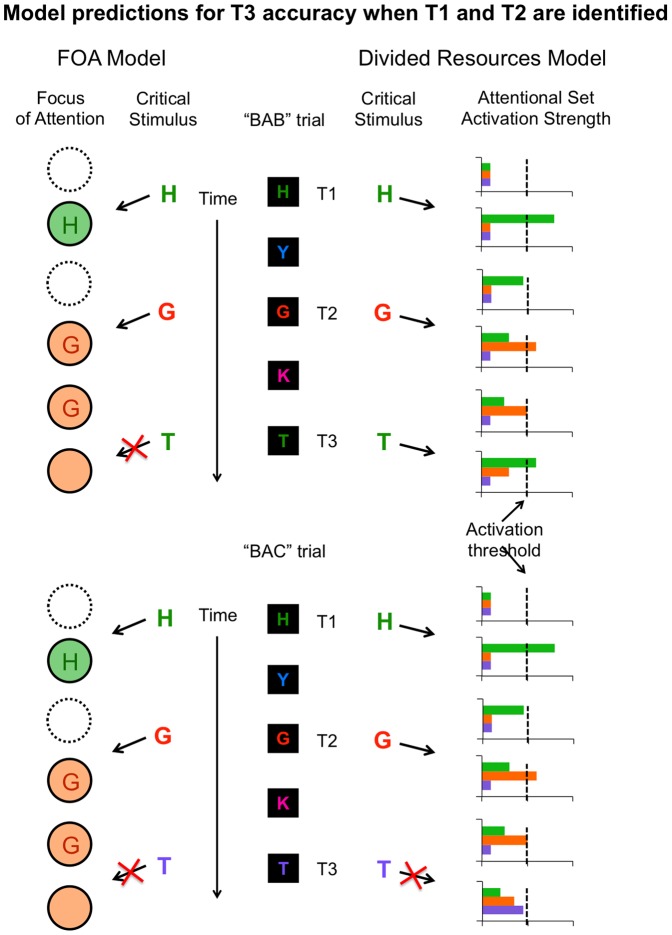
A comparison of the predictions made by the FOA and divided resource models for T3 accuracy in BAB vs. BAC trials when T1 and T2 are both identified.In the FOA model (left), identifying a target letter requires the corresponding attentional set to be enhanced inside the FOA. In each trial, the focus is empty prior to the appearance of the first target, as indicated by the circle with the dotted line. If a target is identified, the corresponding set enters and occupies the FOA, as indicated by the change in color of the FOA. No other set can be enhanced at the same time, as indicated by a solid line around the focus. Given these assumptions, the FOA model predicts that T3 is equally unlikely to be identified in BAB and BAC trials because T2’s set already occupies the FOA when T3 appears. In the divided resources model (right), an attentional set can be activated in a graded manner. In order for a target to be identified, its corresponding set must be activated above a certain threshold level, as depicted by the dotted line. Critically, the divided resources model predicts that T3 is more likely to be identified in BAB than in BAC trials because, in BAB trials, there is lingering enhancement of T1’s set even after T2’s set has been activated and T2 has been identified. This lingering enhancement should make it relatively easy for T3’s set (which matches T1’s set) to reach the activation threshold for identification. In BAC trials, there is no lingering enhancement of T1’s set, which should make it relatively hard for T3’s set to reach the activation threshold.